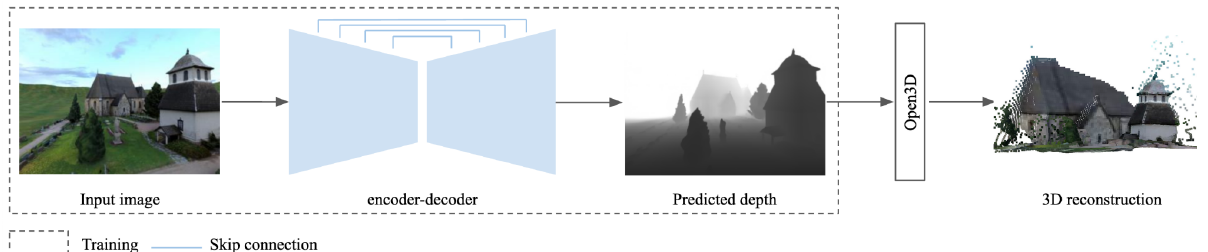
Figure 1. The pipeline of our method is based on an encoder-decoder architecture with skip connections for monocular depth prediction. An additional module for 3D reconstruction is also employed